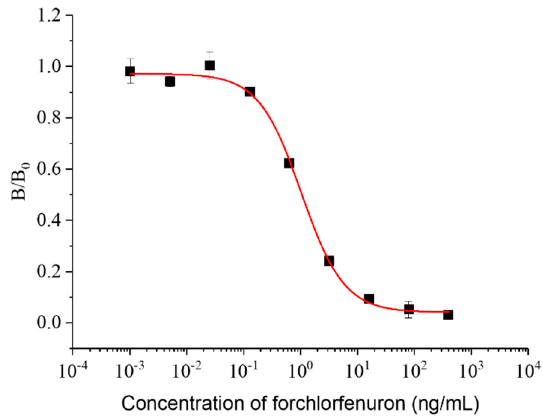
Figure 4. Standard curve for icELISA ( n = 3). The IC 50 for CPPU was 1.04 ng/mL, the LOD was 0.16 ng/mL, and the linear range was 0.31–3.43 ng/mL.